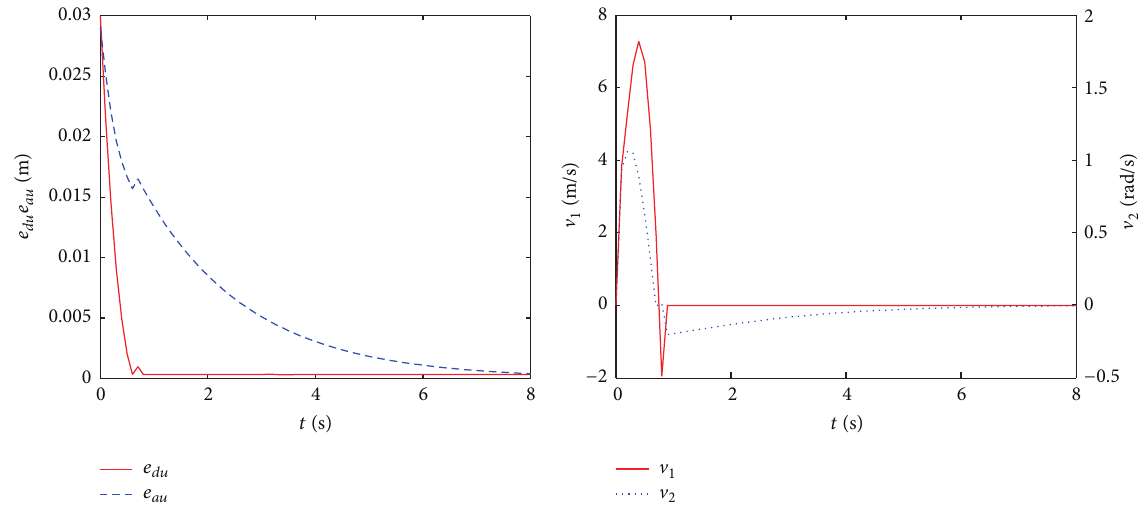
Figure 9: The second step. (a) The epipole of current configuration 𝑒 𝑎𝑢 and the epipole of desired configuration 𝑒 𝑑𝑢 in the second step. The 𝑒 𝑒 𝑎𝑢 and 𝑑𝑢 will be zero in finite time. (b) The linear velocity of the robot